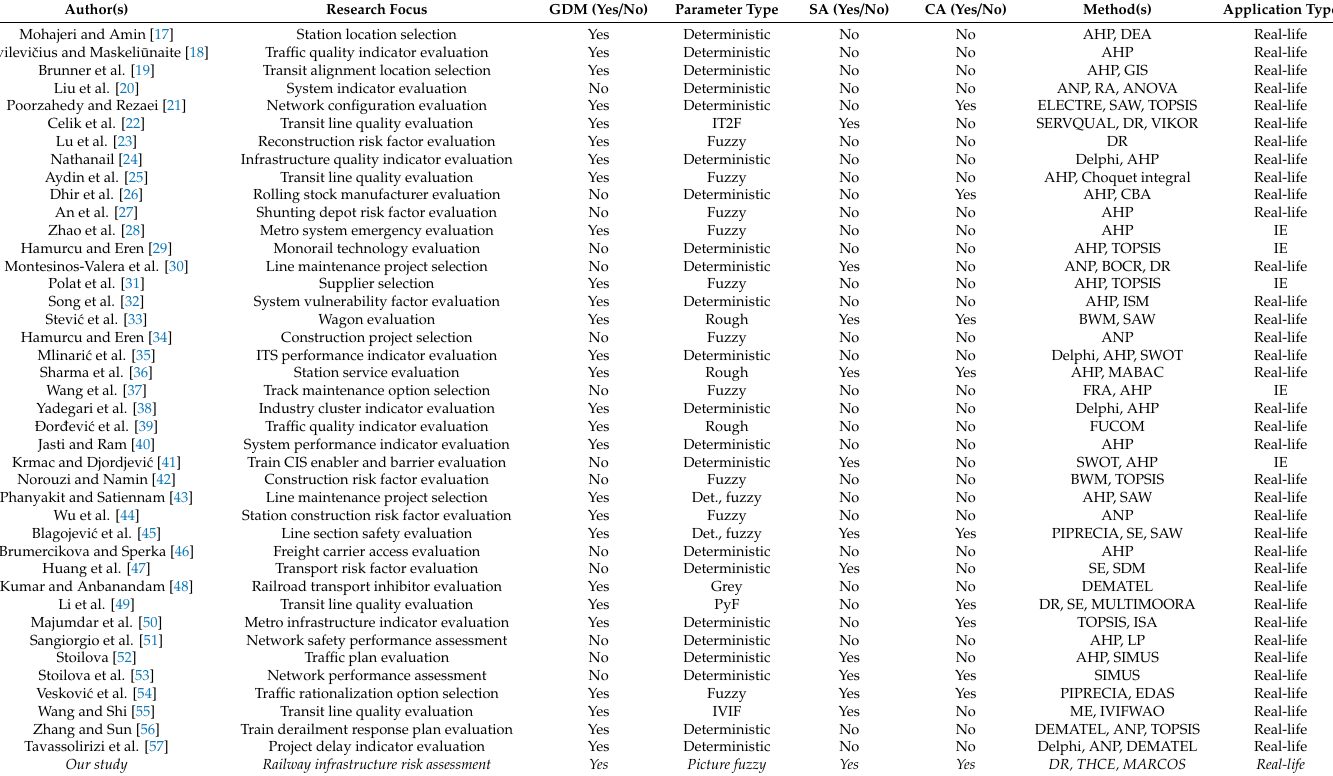
Table 1. Summary of the available MCDM approaches for railway